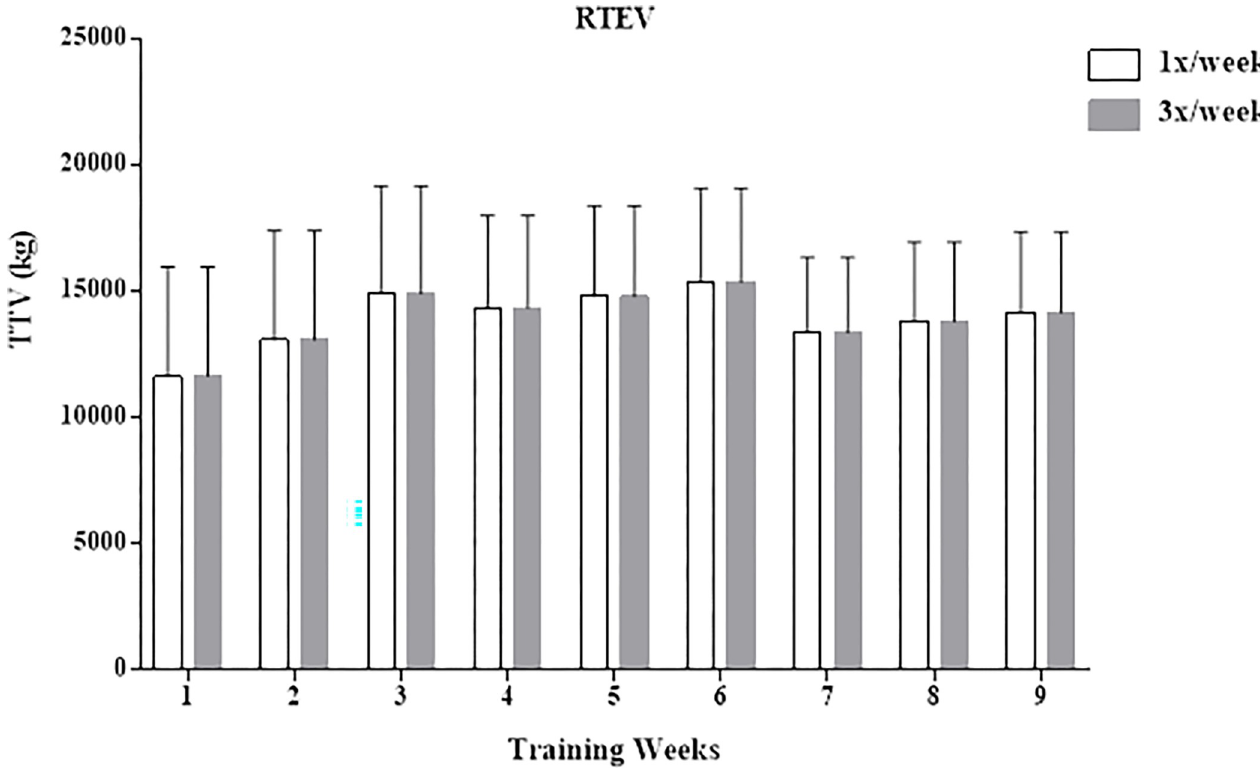
Fig 1. Total training volume per week at different frequencies of RTEV. TTV, total training volume; RTEV, resistance training with equalized total training volume.